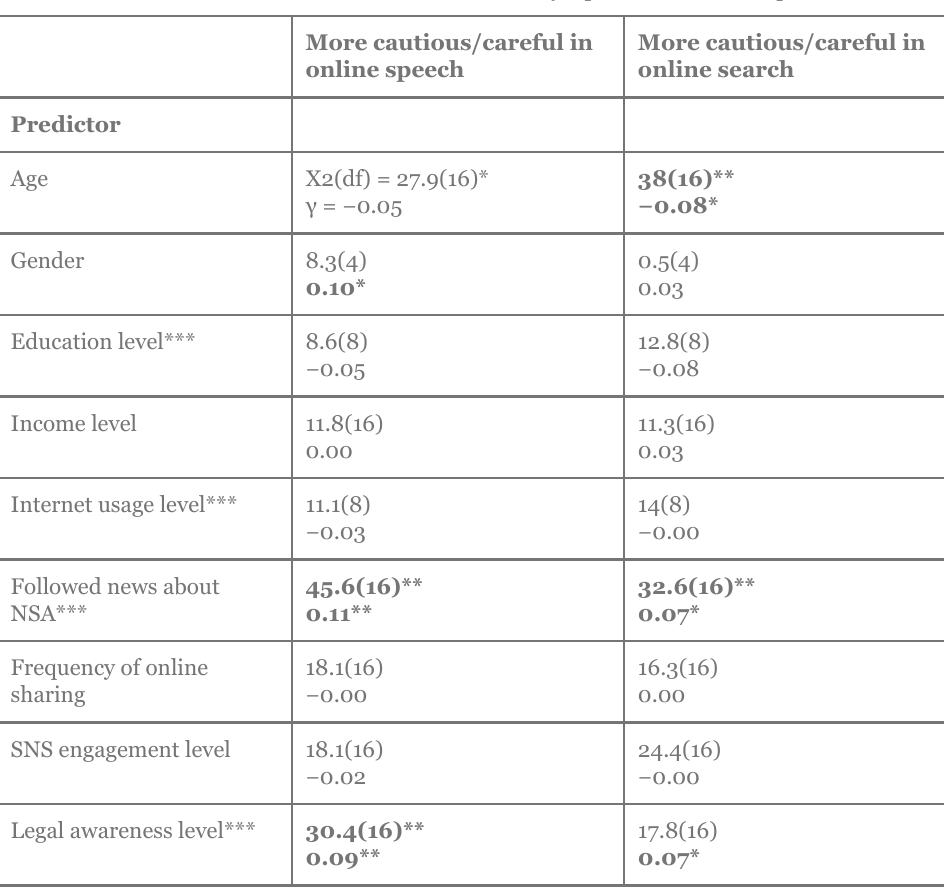
Table 5 − Friend posting about receiving legal notice/threat (#5): chi-square ( Χ 2) and gamma (γ) test results predicting respondents being more careful and cautious in their online speech and searches after made aware a friend has received a threatening legal notice for unauthorised/illegal downloading